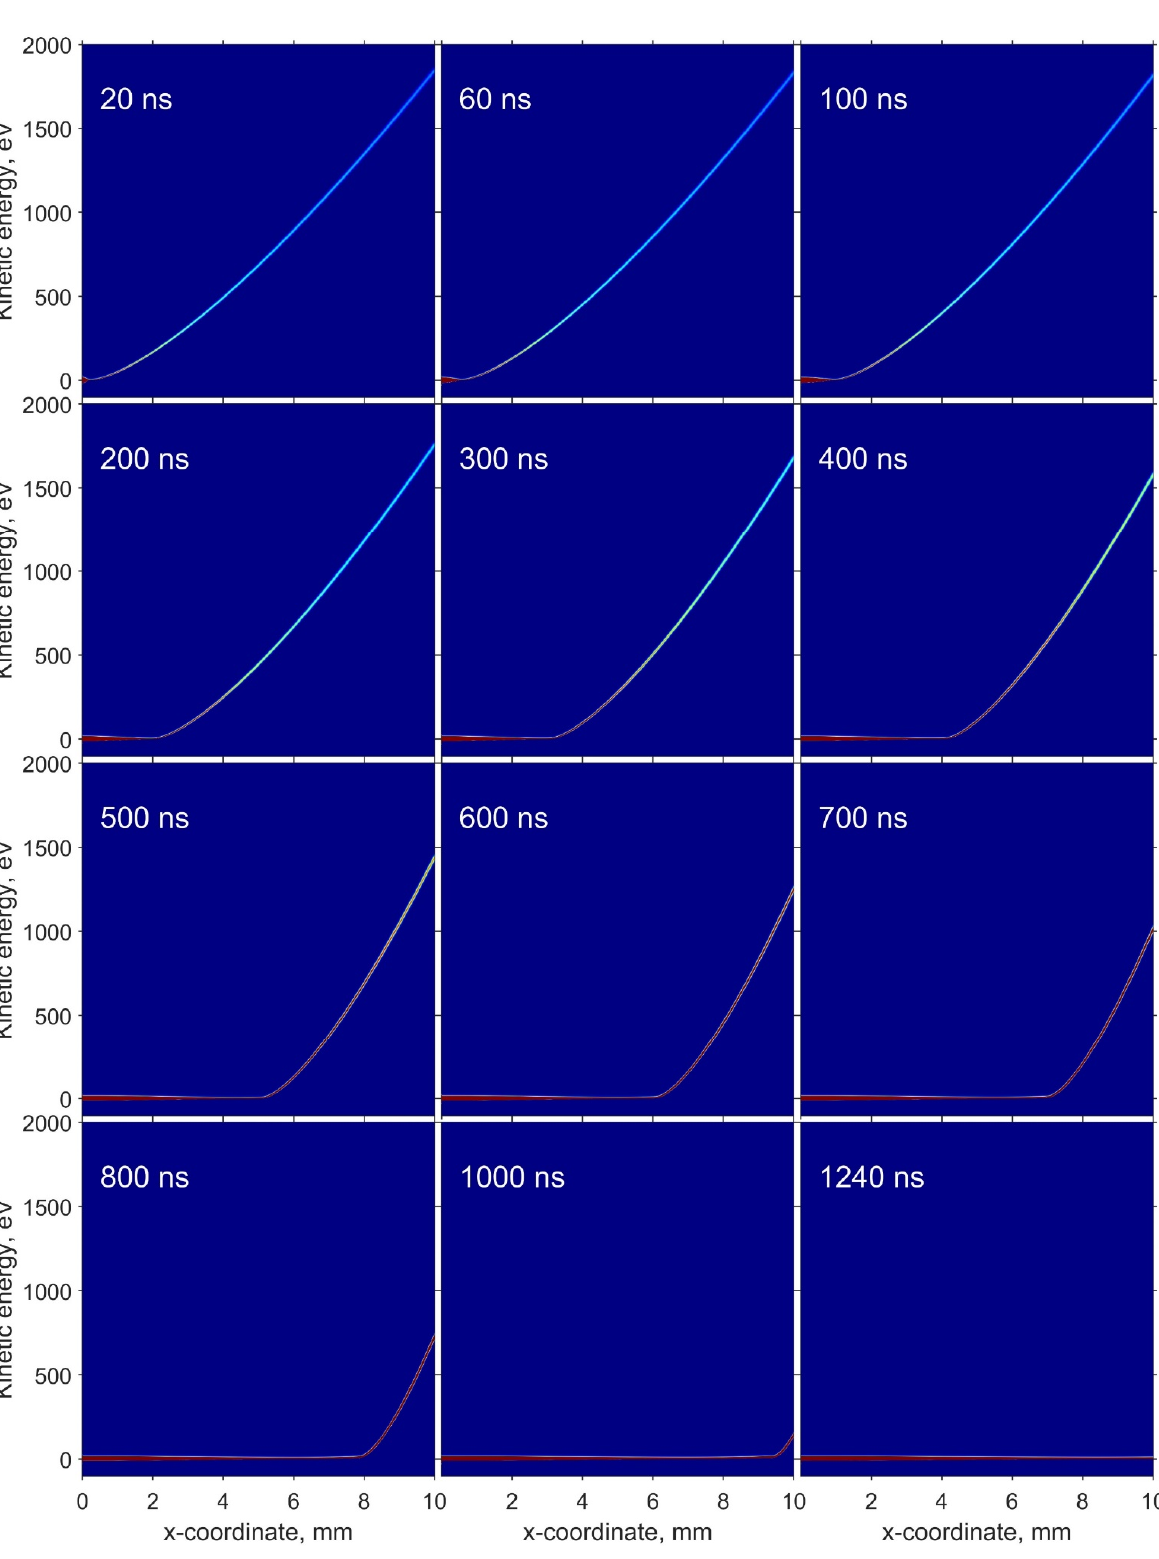
Figure 2. Density plots of the electron distribution function given at selected time steps for the vacuum breakdown simulation in a diode with antimony cathode (arbitrary units).